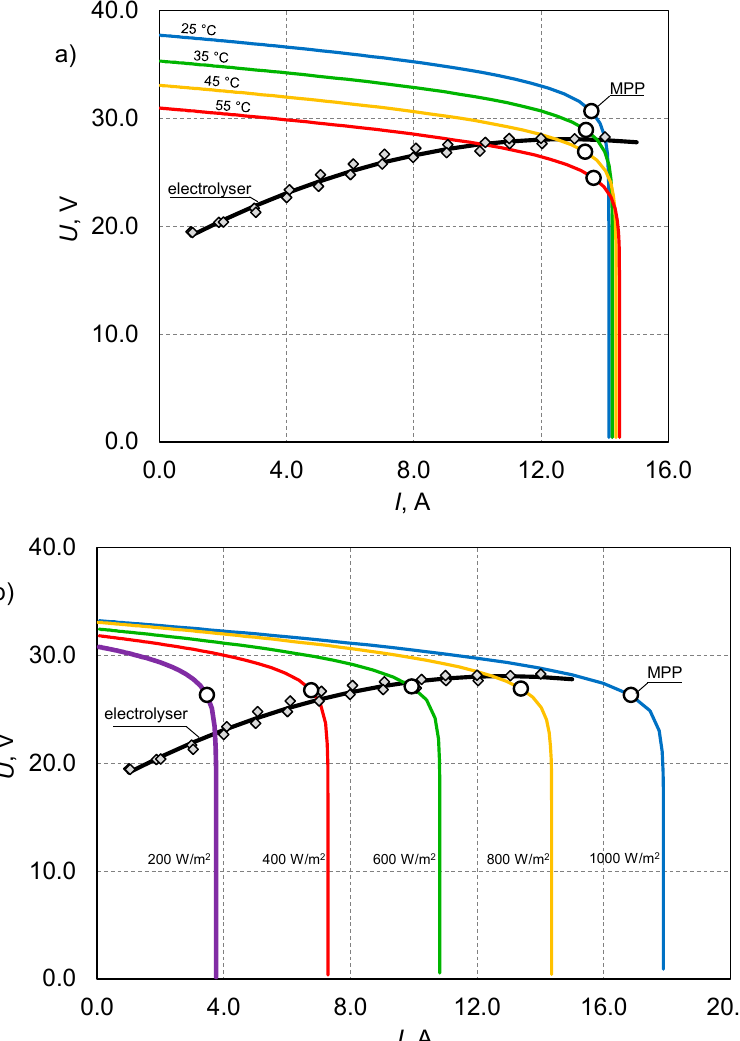
Figure 10. The current–voltage characteristics of two PEM electrolyzers connected in series, and the characteristics of two photovoltaic panels connected in parallel: ( a ) at different temperatures (irradiance 800 W/m 2 ), ( b ) at different irradiance (panel temperature 45 °C).